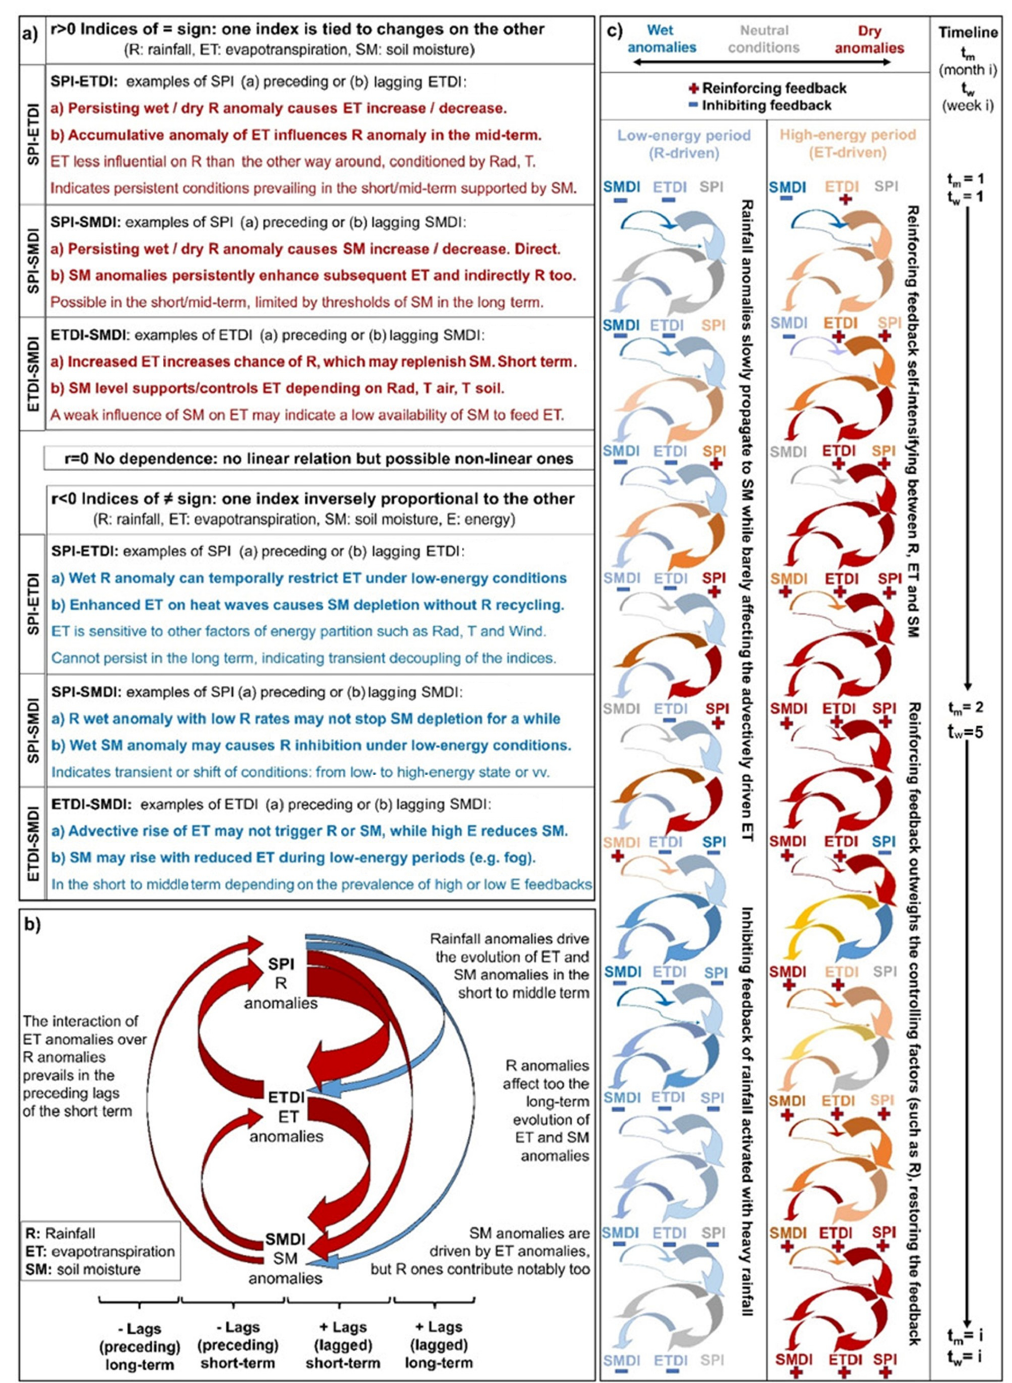
Figure 8. (a) Interpretation of the correlations between the SMDI–SPI, ETDI–SPI and SMDI–ETDI. The r > 0 box exemplifies positive correlations between the indices (positive correlations of red arrows in panel b ), while the r < 0 box defines the negative ones (negative correlations of blue arrows in panel b ). The abbreviation “vv” denotes vice versa. (b) Summary of the annual magnitude and timing of the interactions. Red arrows represent positive correlations and blue arrows the negative ones. Arrow width represents the magnitude of the correlation. Arrow direction determines the direction of the interaction. The timeline at the bottom indicates the scale of the interactions ranging from short-term to long-term. (c) Sequences of prevalent reinforcing (upper) and inhibiting (lower) conditions alternating during the annual cycle based on the scheme of interactions described in panels (a) and (b) . The upper sequence is the self-intensifying loop driven by evapotranspiration under high-energy conditions. The lower sequence displays the inhibiting role of rainfall and soil moisture under low-energy